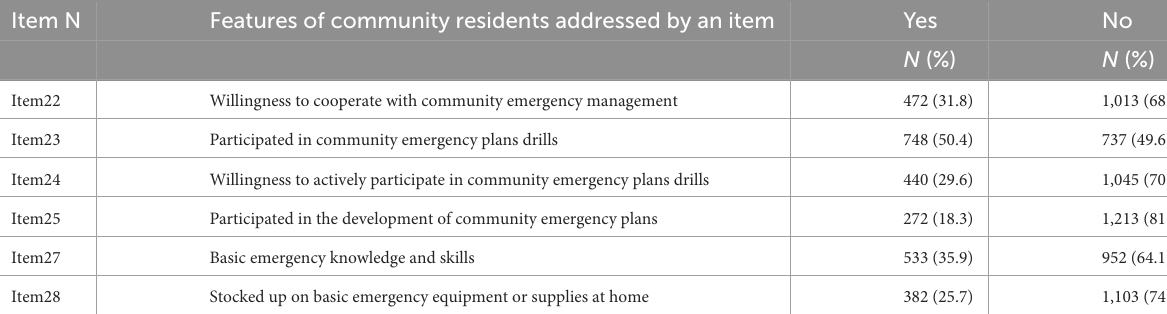
TABLE 4 Questionnaire responses to items about the “target group.”